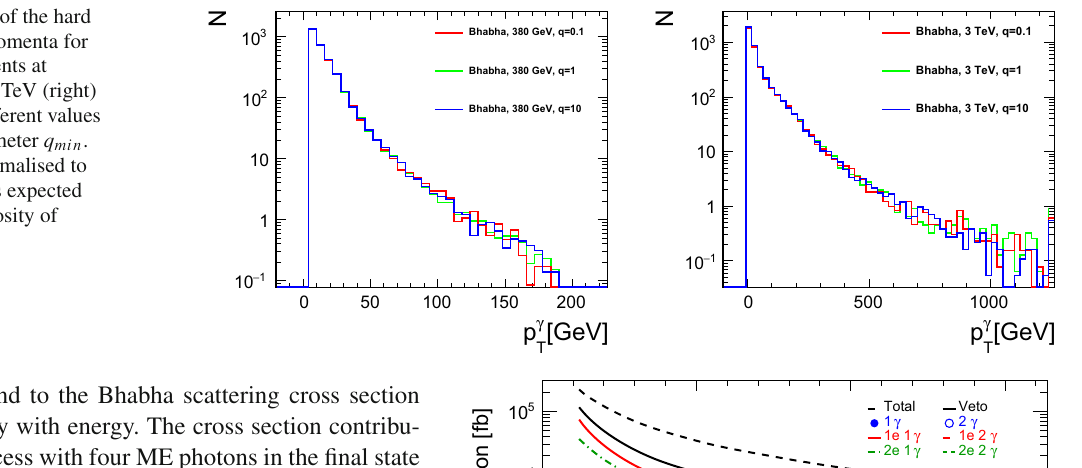
Fig. 7 Distribution of the hard photon transverse momenta for radiative Bhabha events at 380GeV (left) and 3TeV (right) in Whizard , for different values of the merging parameter q min . Distributions are normalised to the number of events expected for integrated luminosity of 1fb − 1